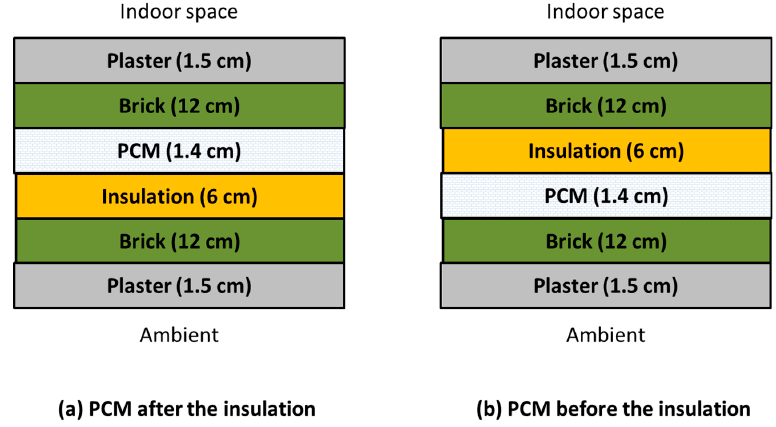
Figure 1. ( a ) PCM after the insulation case; ( b ) PCM before the insulation case.